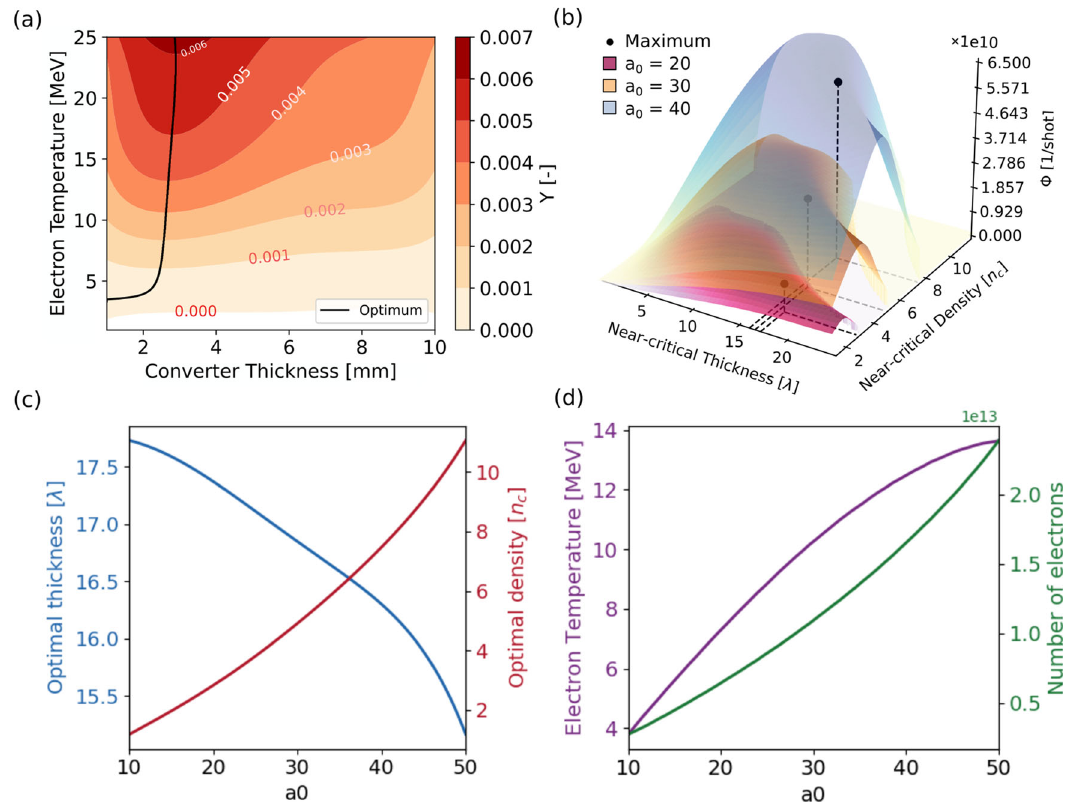
Fig. 3 Parametric scan and model results for laser-driven photon activation analysis (PAA). a Contour plot showing the normalized yield as a function of the laser-driven electron temperature and converter thickness. The black line marks the locus of optimal converter thickness. b Normalized yield per laser shot for three values of a 0 (i.e., 20, 30, and 40) as a function of the target near-critical layer density and thickness. The positions of the maximum values are marked with black dots. c Trends for the optimal near-critical layer thickness and density as a function of a 0 . d Trends for the electron temperature and the number of accelerated electrons per shot as a function of a 0